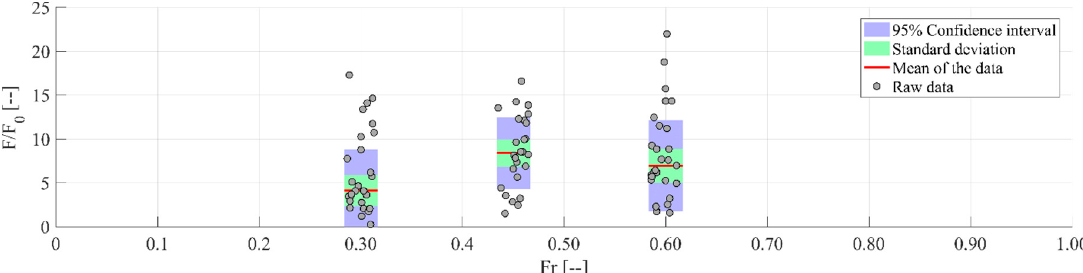
Figure 15. Load on the obstacles as a function of the Froude number. All equilibrium forces are displayed as the grey dots; the mean of the data is displayed by the solid red line.